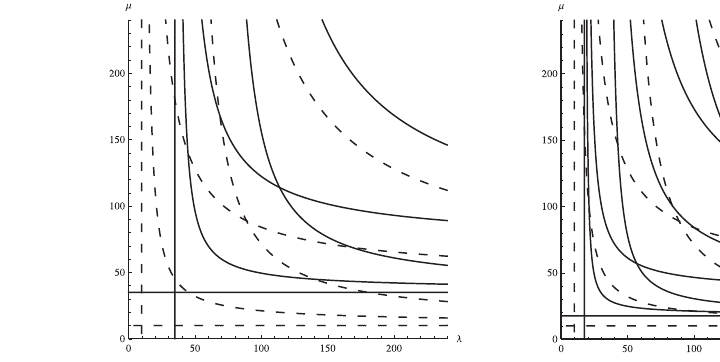
Figure 1. The Fuˇc´ık type spectrum Σ F (1 , 5) (solid) can be obtained from the classical Fuˇc´ık spectrum Σ F (1 , 0) (dashed) by the translation parallel to the vector (5 2 , 5 2 ).